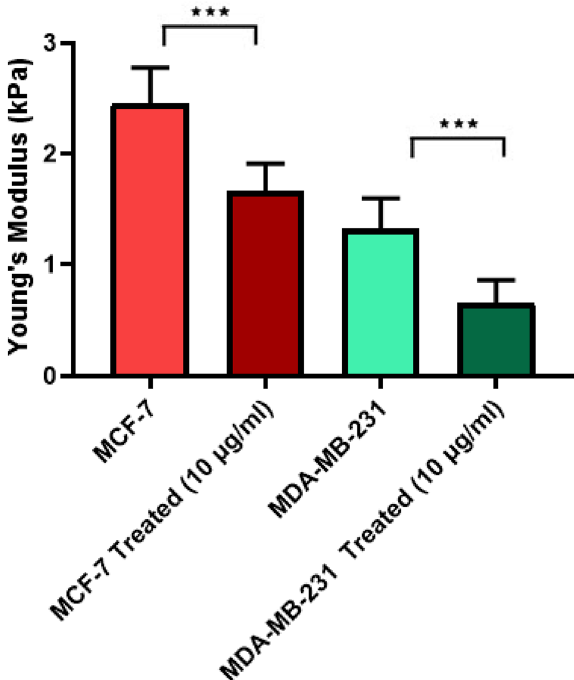
Figure 4. The effect of GO nanosheets Young’s modulus of MCF-7 and MDA-MB-231 cell lines. The data represent the mean ± standard deviation of Young’s modulus of MCF-7 and MDA-MB-231 cell lines obtained from six independent experiments. Two-way ANOVA was used to analyze the difference between treated and control groups and * P < 0.05, ** P < 0.01, *** P < 0.001, and **** P < 0.0001.